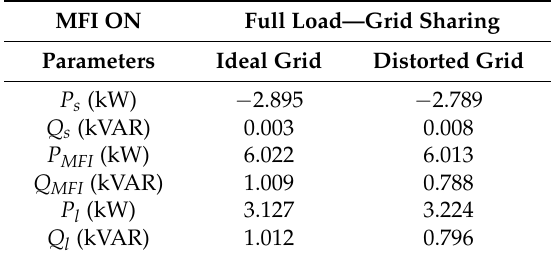
Table 5. Active and reactive power summary of the source, MFI, and load under grid feeding mode. MFI